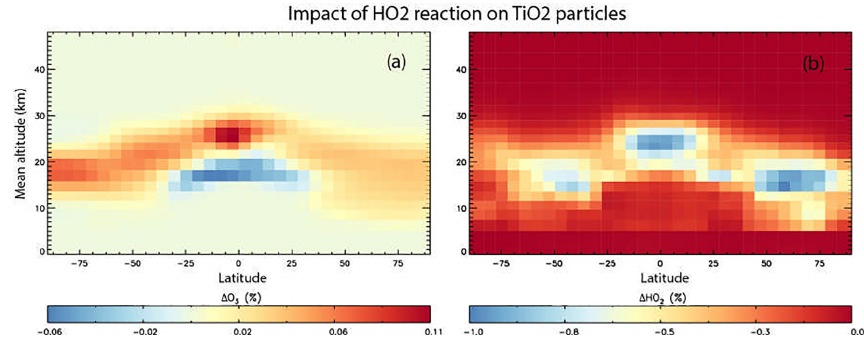
Figure 9. Annual mean change (%) in atmospheric O 3 (a) and HO 2 (b) calculated using the TOMCAT 3-D model from inclusion of heterogeneous loss of HO 2 on TiO 2 particles for 2008, and using γ (HO 2 ) =